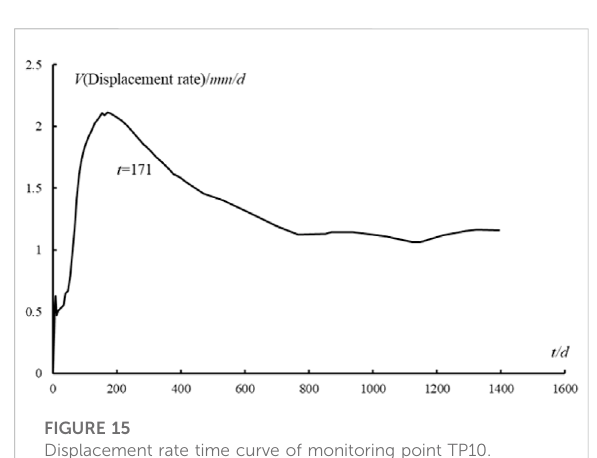
FIGURE 14 Planeresultantdisplacement – timecurveofmonitoringpoint TP10.